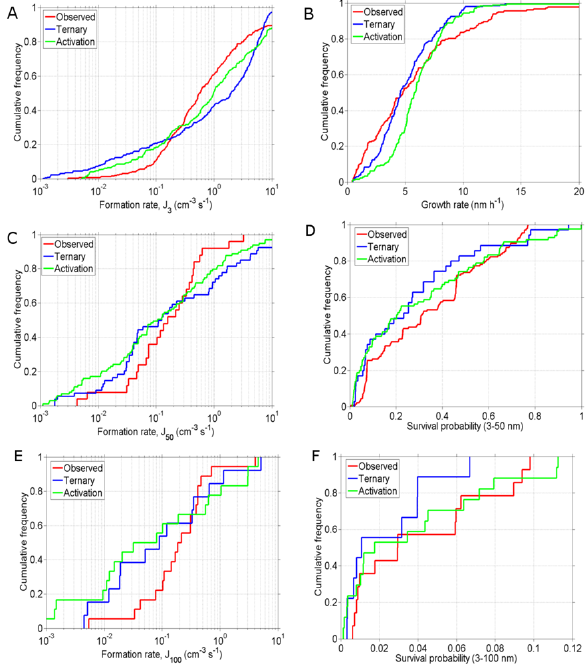
Fig. 9. Same as in Fig. 5, for modeled and measured nucleation metrics at San Pietro Capofiume, Po Valley